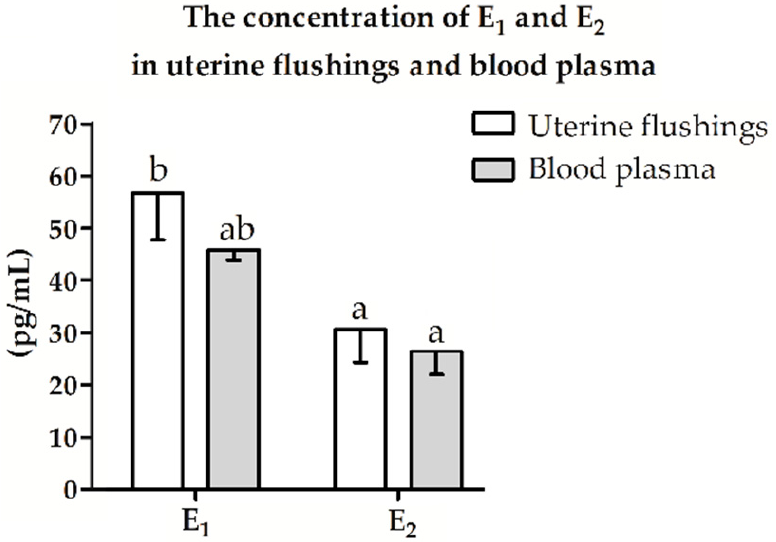
Figure 6. The concentration of estrone (E 1 ) and estradiol-17 β (E 2 ) in uterine flushings and blood plasma of pigs during days 15–16 of early pregnancy. Data are presented as mean ± SEM. Lower-case letters (a, b) above bars indicate statistically significant differences p ≤ 0.05 (multi-way